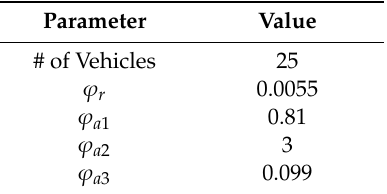
Table 2. Parameters of the simulation.